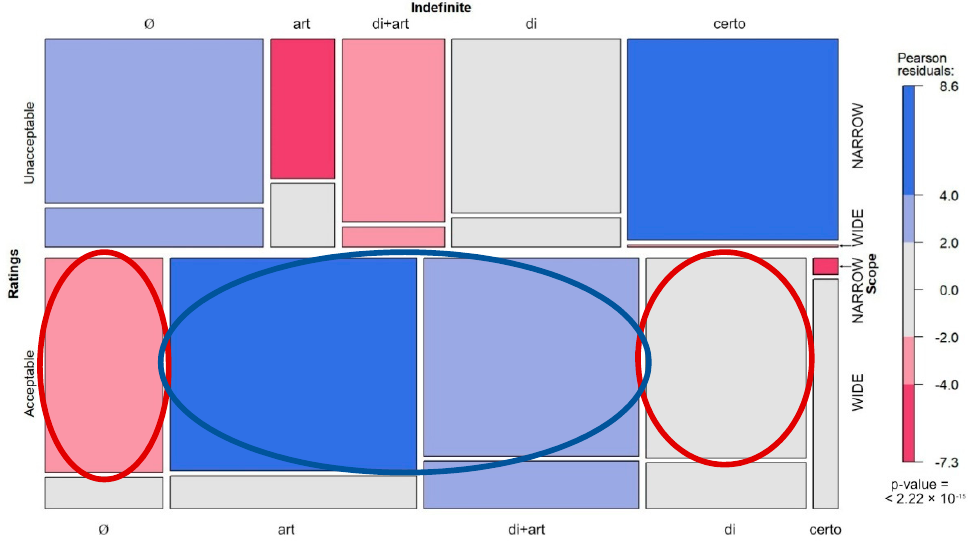
Figure 10. (Un)acceptability rate of each indefinite determiner with wide and narrow scope. The red circles highlight the similar behavior of ZERO and bare di , while the blue circle indicates the similar behavior of ART and di +art.